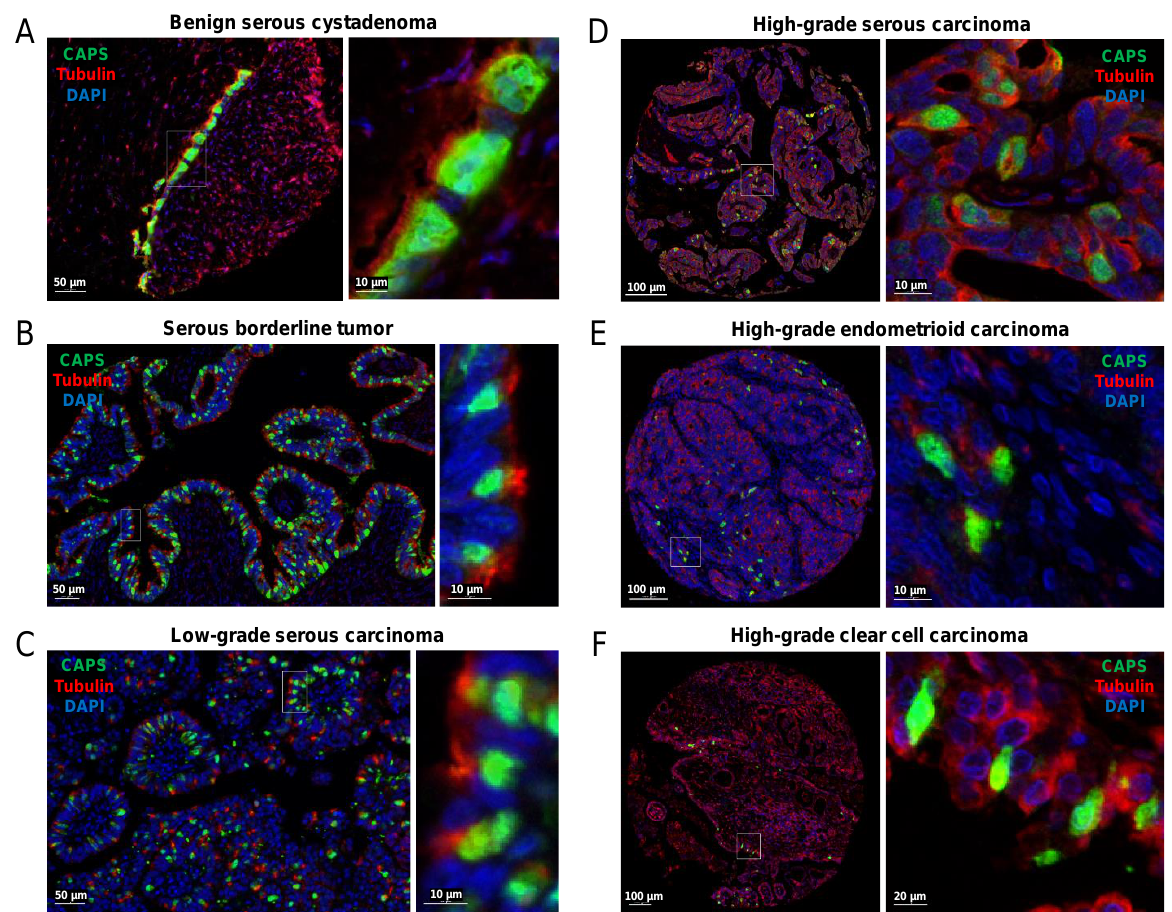
Figure 2. Ciliated cell markers CAPS and TUBB4 (mIF) in ( A ) benign serous cystadenoma, ( B ) serous borderline tumor, ( C ) serous low-grade carcinoma, ( D ) HGSOC, ( E ) high-grade endometrioid carcinoma, and ( F ) high-grade clear cell carcinoma. Images (left) are shown at higher magnification (right).